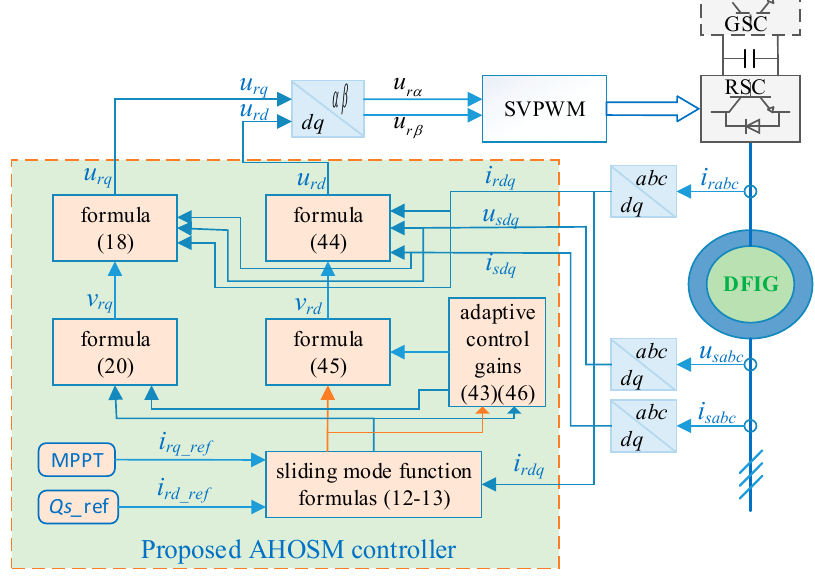
Figure 3. Control structure of the proposed adaptive higher-order sliding model (AHOSM) control scheme.